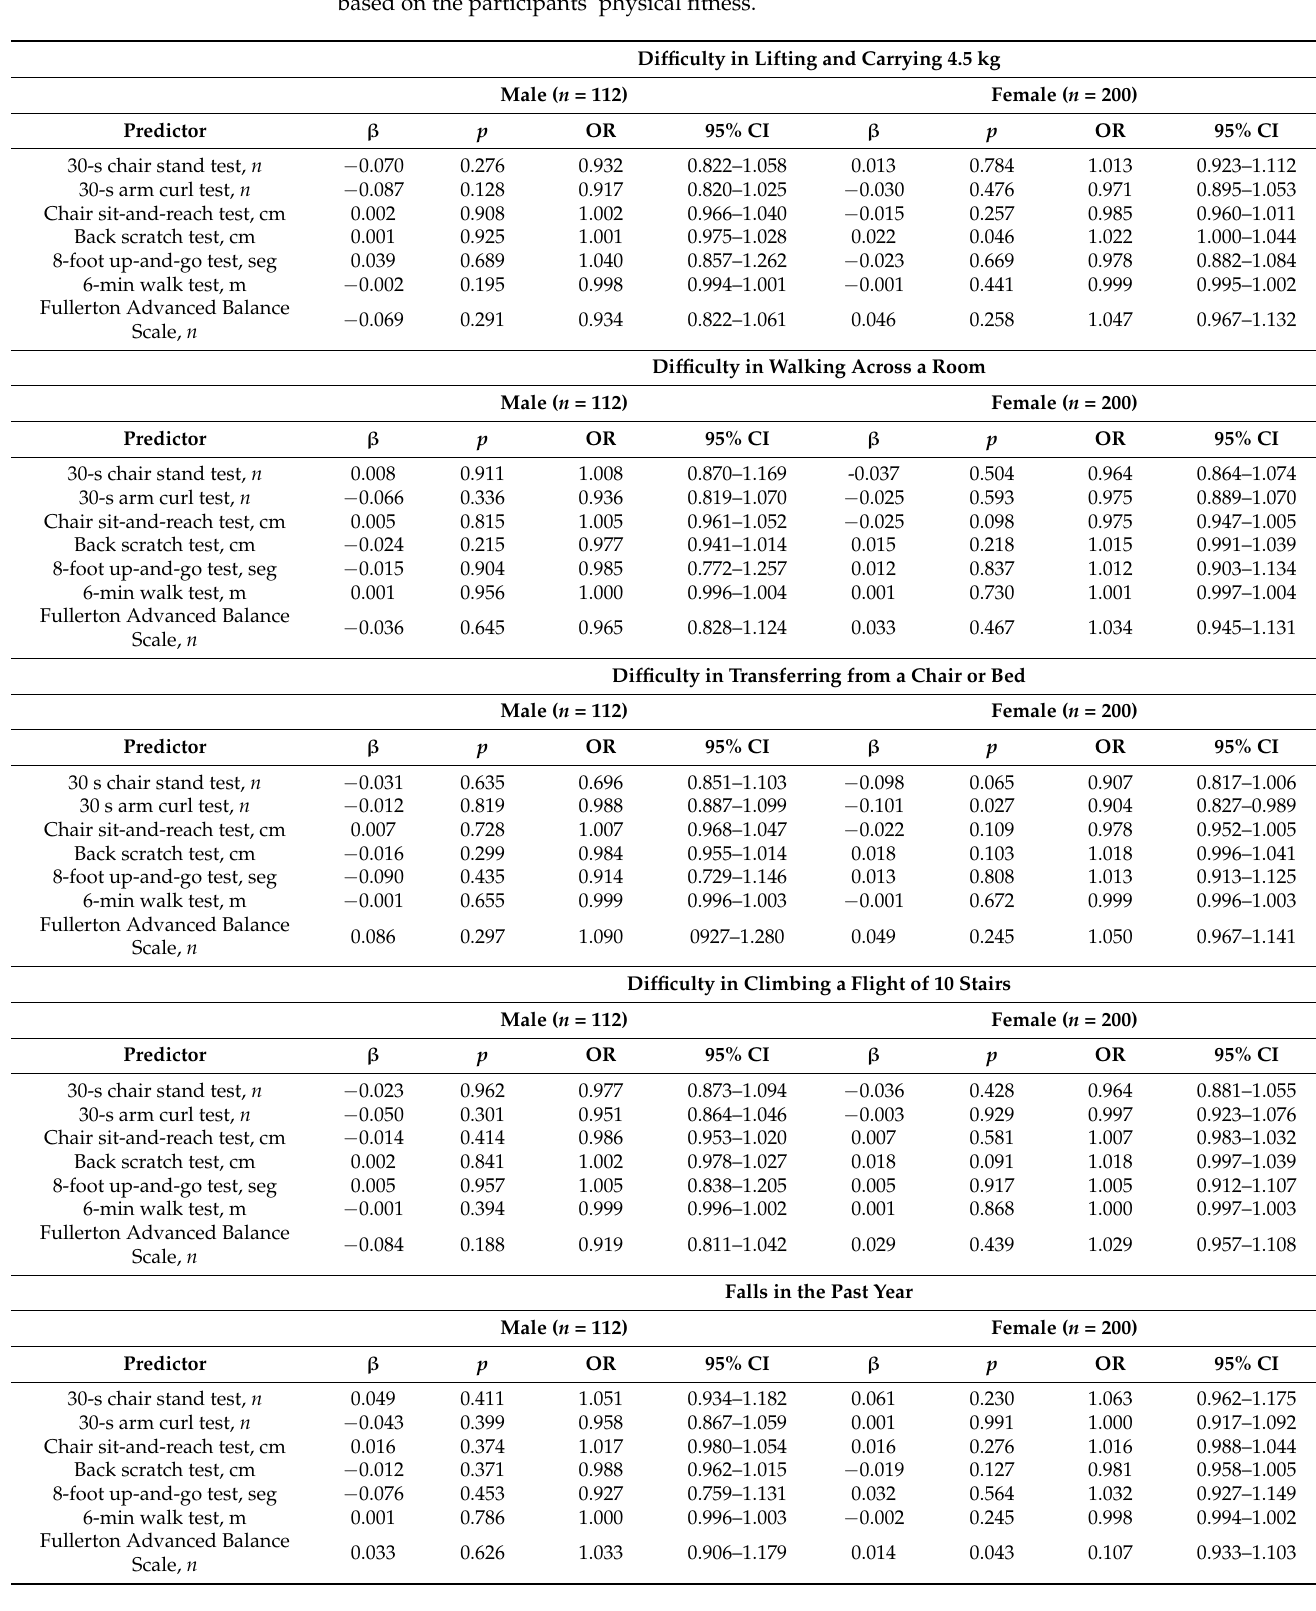
Table 4. Associations through logistic regression between the occurrence of each sarcopenia symptom based on the participants’ physical